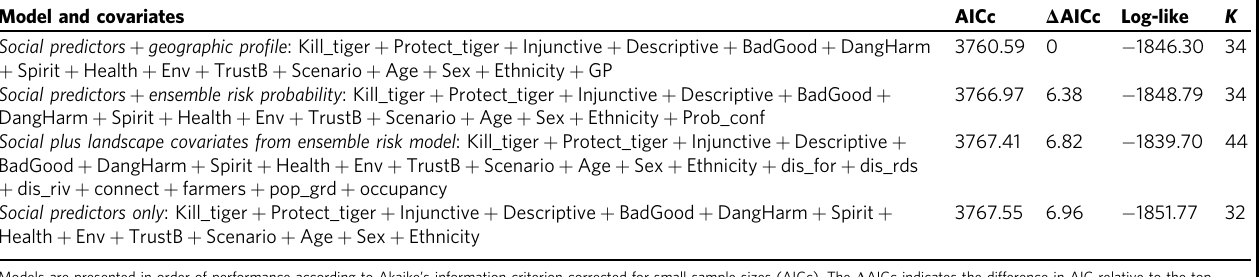
Table 1 Performance of tiger tolerance models with and without landscape covariates or measures of risk Model and covariates AICc Δ AICc Log-like K